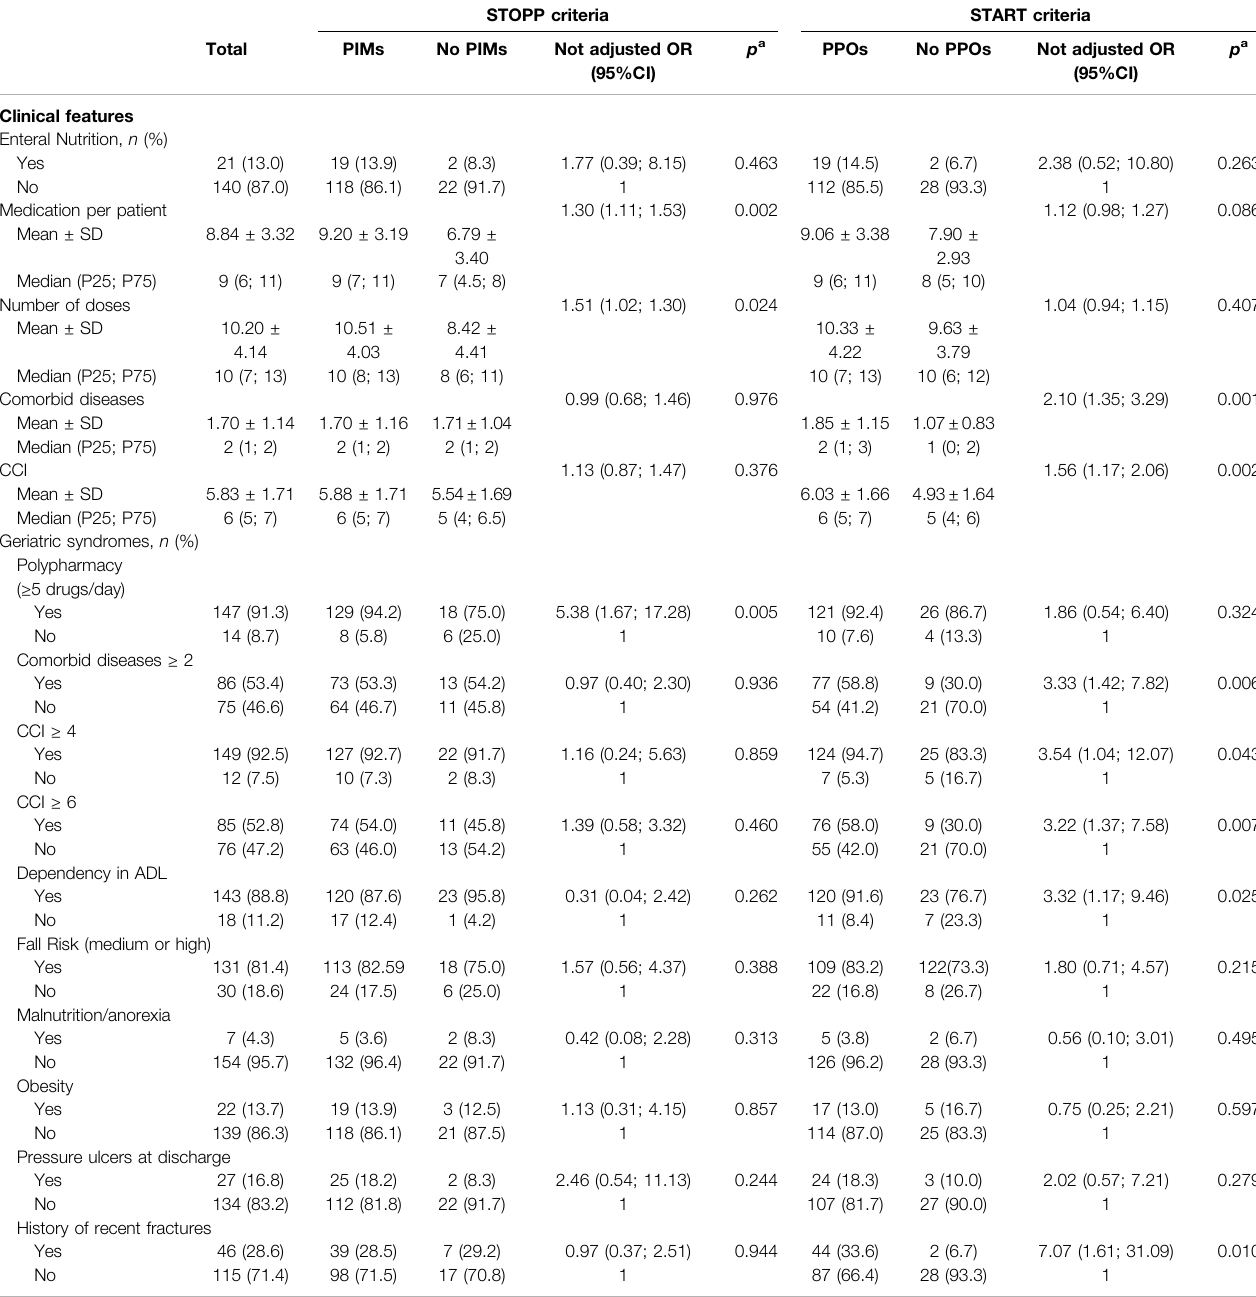
TABLE 2 | Clinical features of study population ( N (cid:1) 161) that received post-acute care and long-term care in Units for Integrated Continuous Care ( Unidades de Cuidados Continuados , UCCI) inserted in the Portuguese National Network for Long-term Integrated Care ( Rede Nacional de Cuidados Continuados Integrados , RNCCI). STOPP criteria START criteria Total